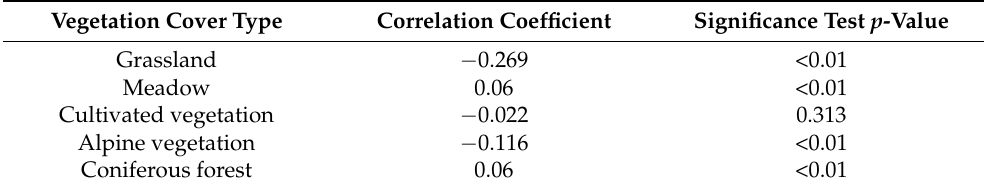
Table 2. Correlation analysis between NDVI and surface deformation for different vegetation types. Vegetation Cover Type